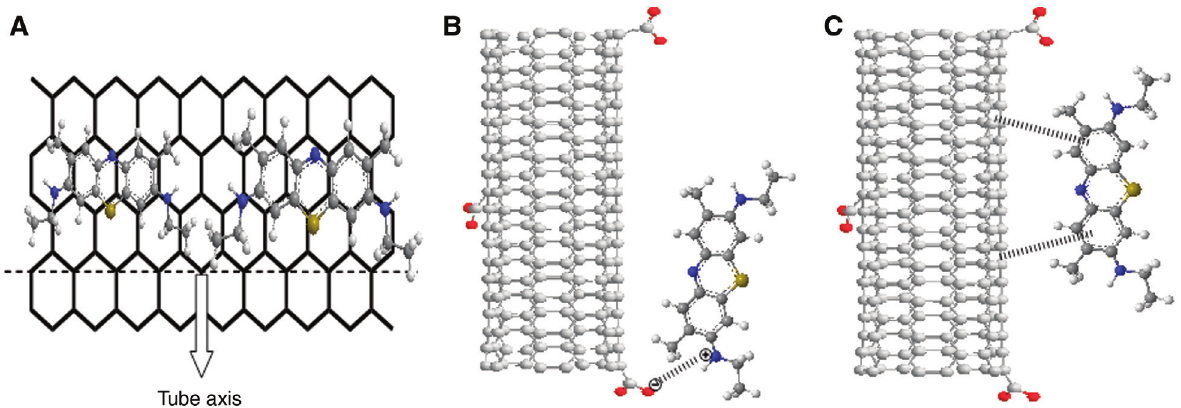
Figure 3: Schematic illustration of typical adsorption sites and the possible interaction between multi-walled carbon nanotubes (MWCNTs) and methylene blue dye: (A) axis direction; (B) electrostatic attraction and (C) π - π stacking.